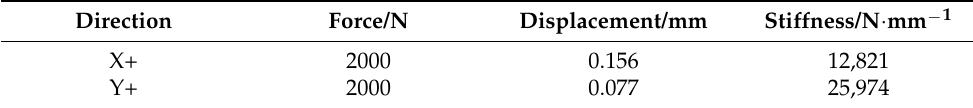
Figure 5. Loading and constraints of suspension control arm. Table 2. Results of stiffness analysis of control arm.